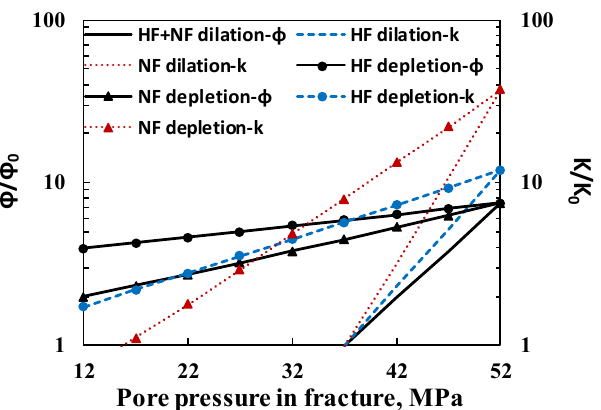
Figure 2. Pressure sensitivity curves for complex fracture from pumping to production period.